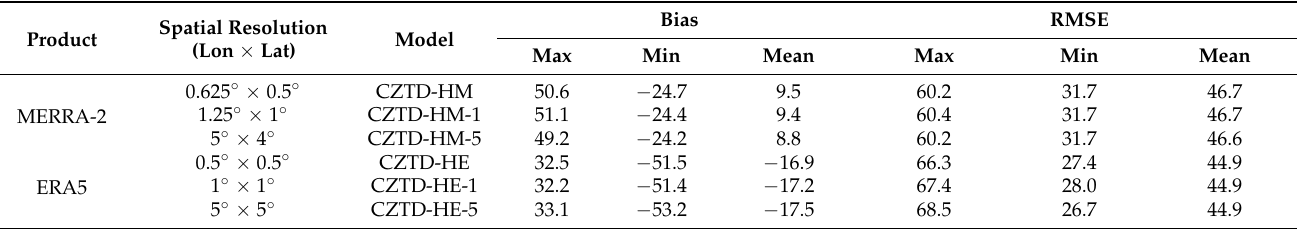
Table 1. Error statistics of ZTD layered vertical interpolation obtained using the CZTD-H model with different spatial resolutions compared with radiosonde data in 2017 (unit mm).